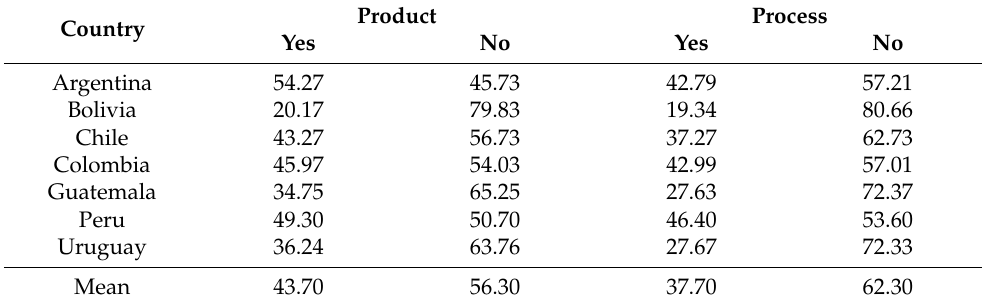
Table 2. Innovation process and product level in